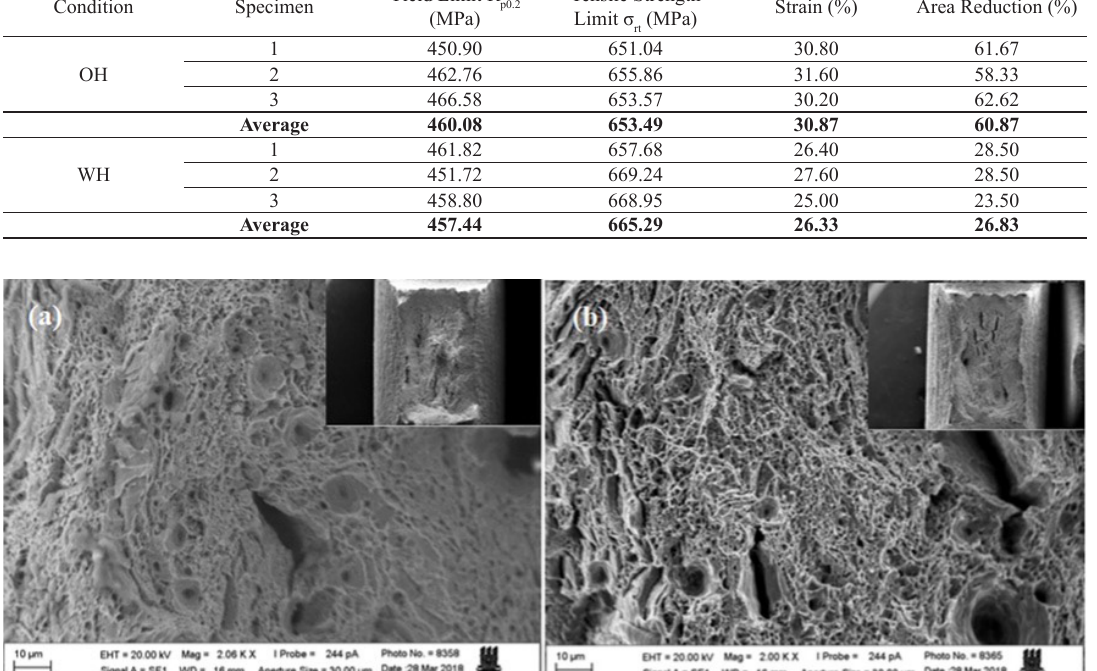
Table 11. Mechanical properties of the welded joint, steel ASTM A182 F22 - Inconel 625 - steel ASTM A36, without (OH) and with (WH) hydrogenation. Condition